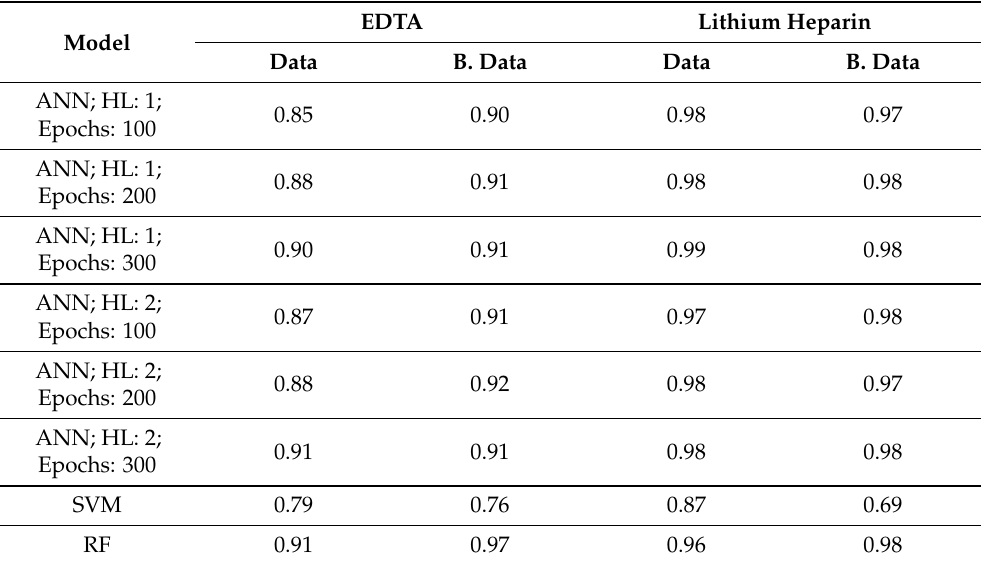
Table 7. Accuracy obtained for each ANN scenario, including the values obtained for the SVM and RF models. Model